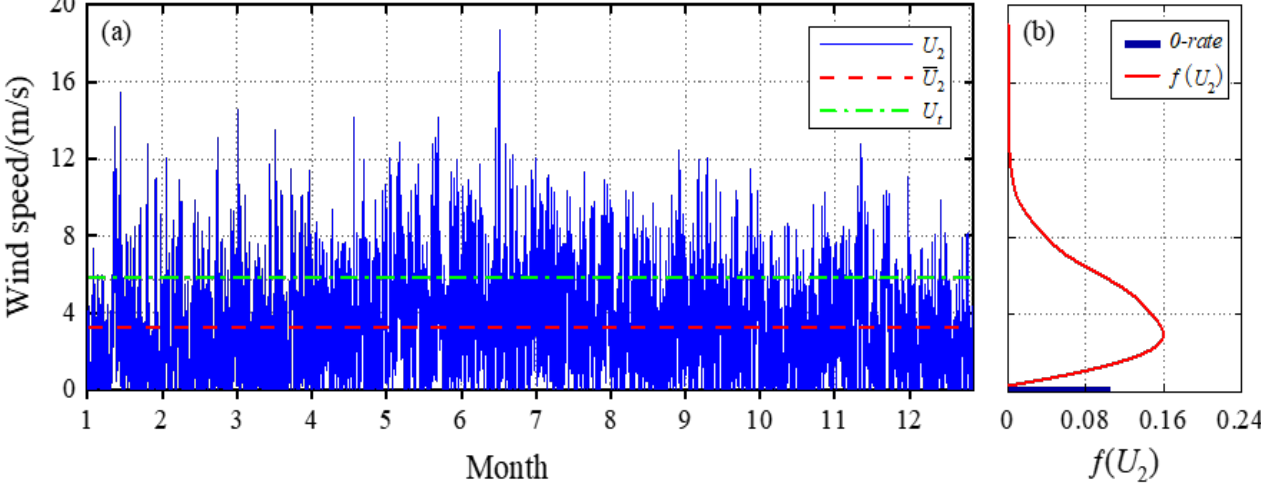
Figure 3. Distribution of non-directional wind speed variation ( a ) Distribution of non-directional wind speed variation ( b ) wind speed probability distribution ( Ut represents the starting wind speed of sand particles at 2 m height in Tengger Desert; U 2 represents the 2 min annual observed variable wind speed in the region; Ū 2 represents the 2 min average annual wind speed in the region).